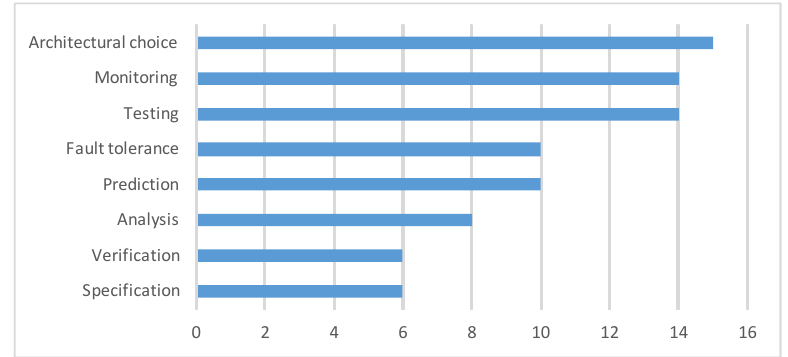
Figure 8. Distribution of Different QA